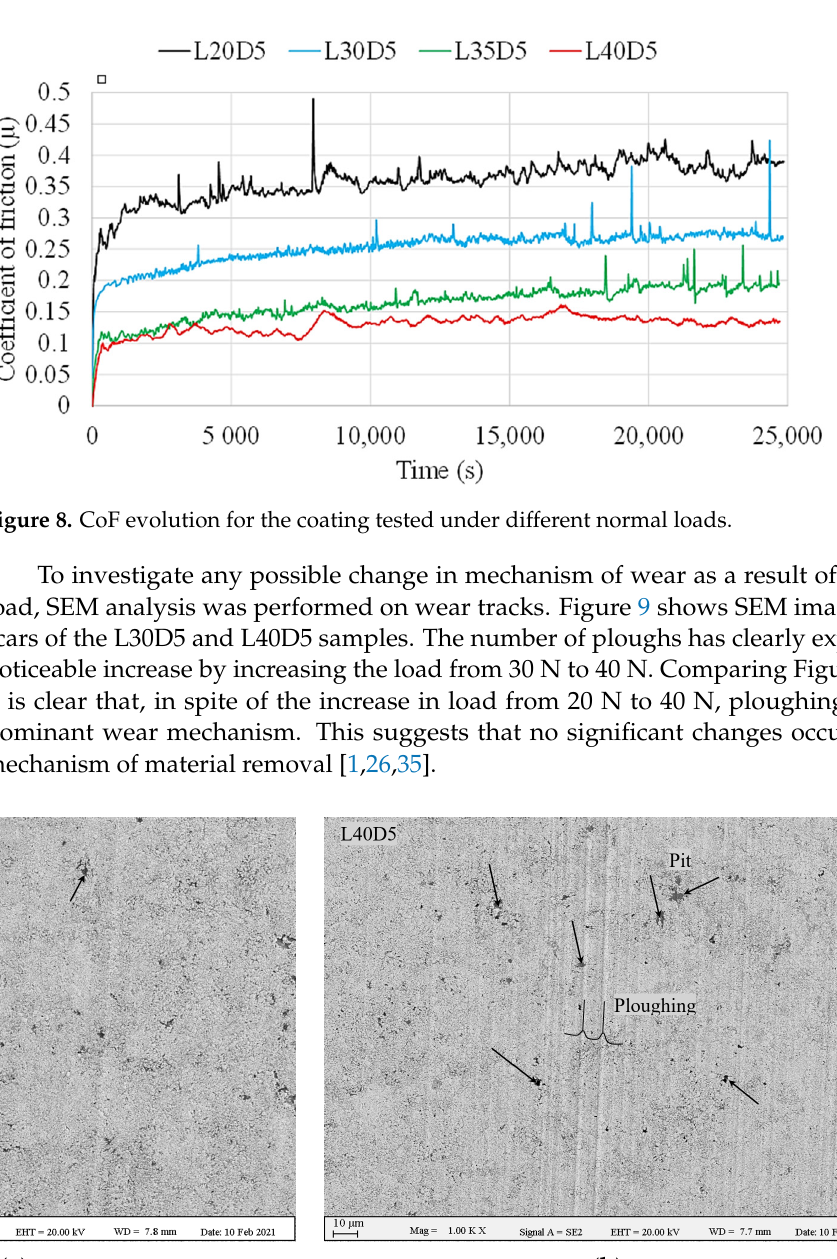
10 of 15 Figure 7. Specific wear rates from ball-on-disc tests conducted under different loads. 3.3.2. Variation in Coefficient of Friction and Wear Mechanism Figure 8 shows evolution of friction coefficient of the samples during the tests per- formed at radius of 7 mm. The height of the CoF plateau is observed to clearly decrease with increasing normal load. A gradual decrease in the average values can be seen when increasing the load from 20 N to 30 N, 35 N and 40 N. This indicates that, in spite of in- crease in normal load, friction load does not experience any considerable change. Alt-